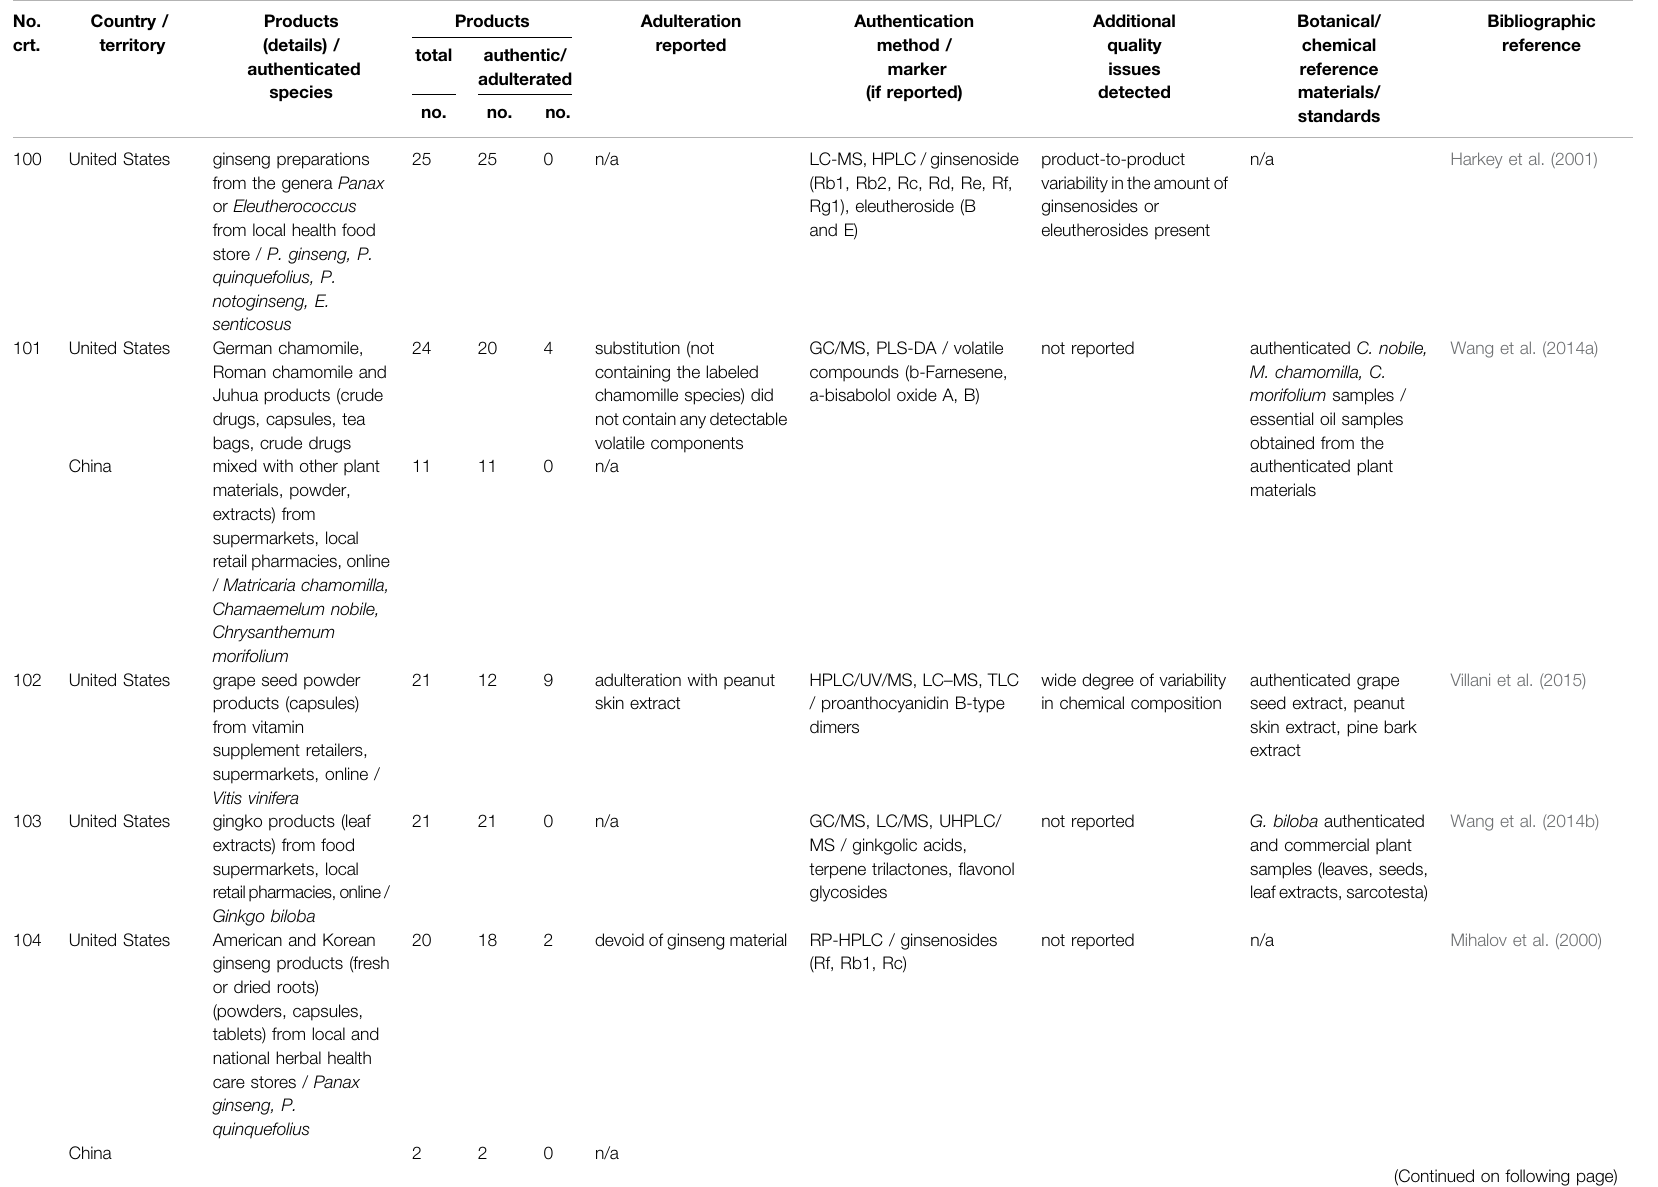
TABLE 1 | ( Continued ) The authenticity of the chemically authenticated commercial herbal products at global